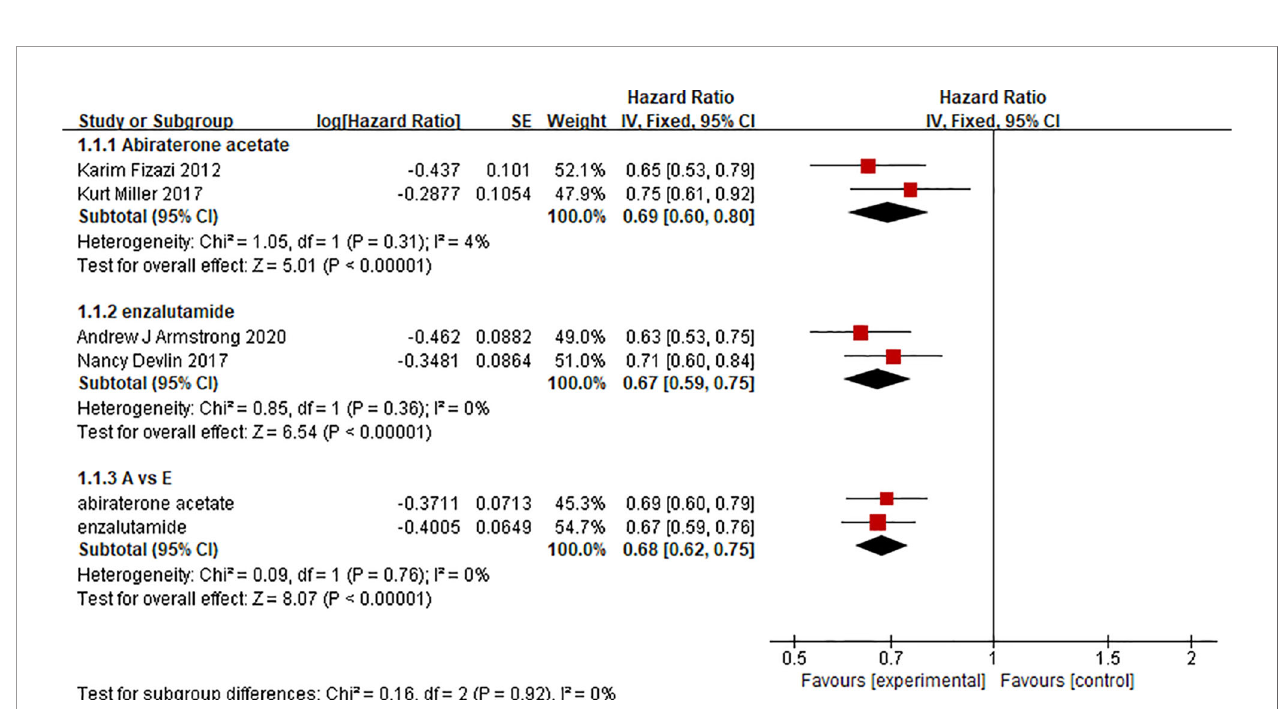
FIGURE 3 | Risk of bias summary. Green circles represent a low risk of bias; red circles represent a high risk of bias; yellow circles represent an unknown risk of